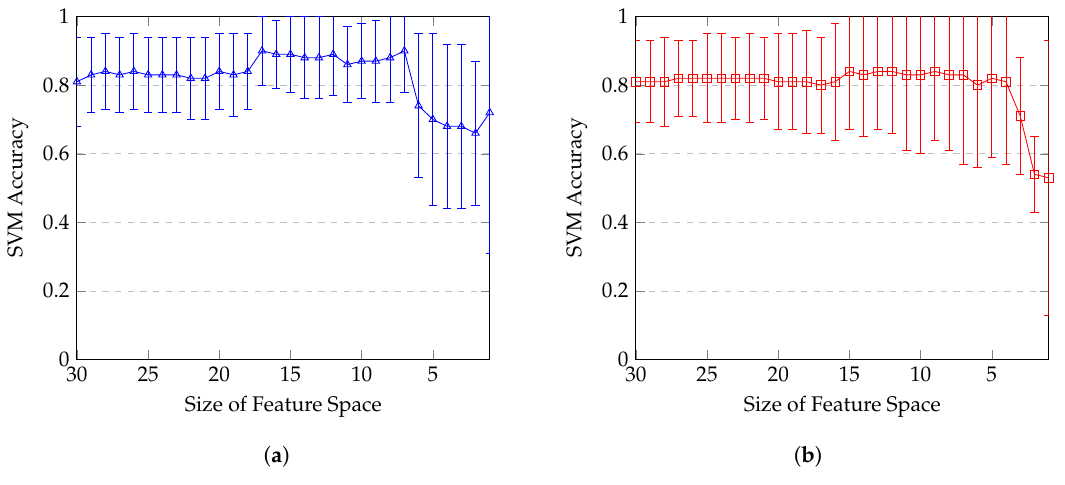
Figure 8. Mean with standard deviation of the accuracy scores from 10-fold cross-validation for SVMs with decreasing number of features. Features order is given by Fisher (see Table 6) and mRMR (see Table 5) algorithms. ( a ) Fisher ranking features; ( b ) mRMR ranking